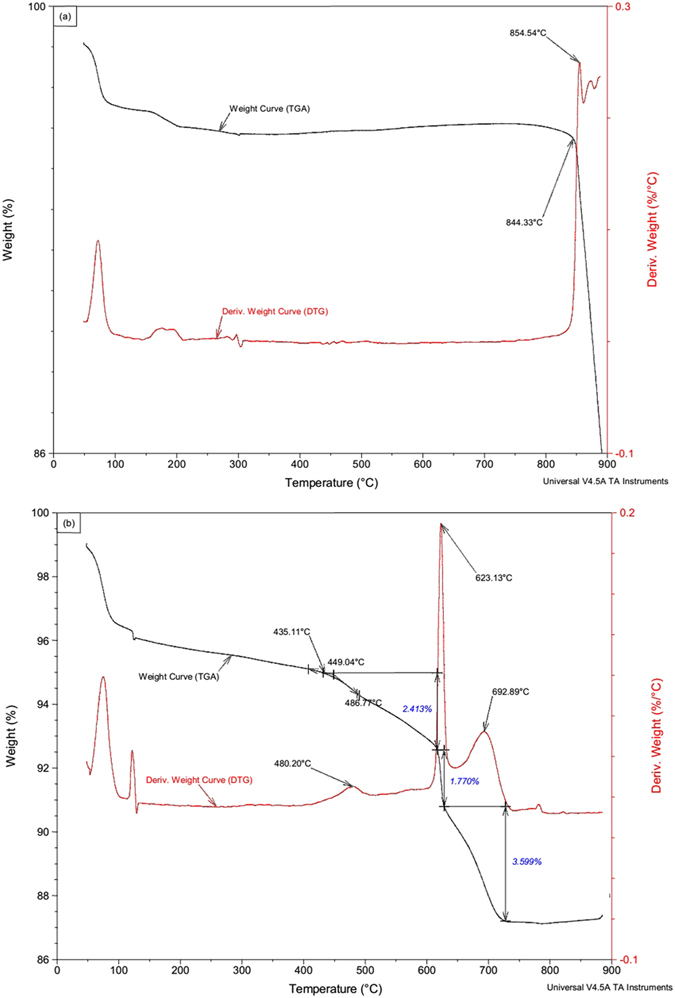
TGA and DTG curves of Na2CO3 (a) and a mixture of Na2CO3 and SiO2 (b).